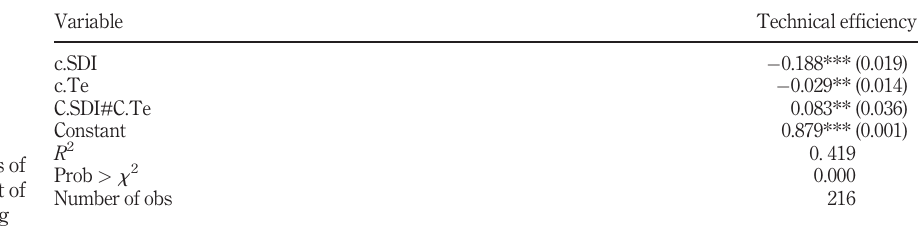
Table 6. Estimated results of